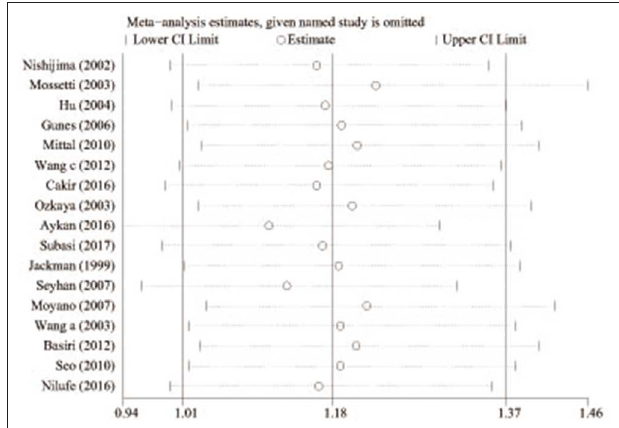
FIGURE 4 | Sensitivity analysis of the pooled ORs and 95% CIs for TaqI variant (tt allele vs. TT allele).